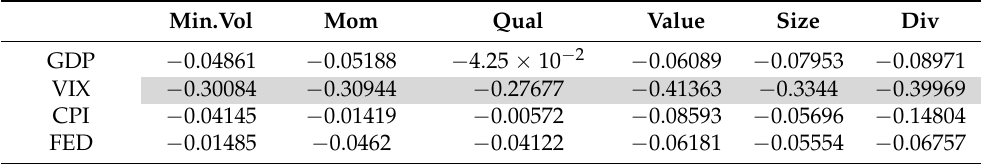
Table 4. Pearson correlation between smart beta returns and macroeconomic time series.